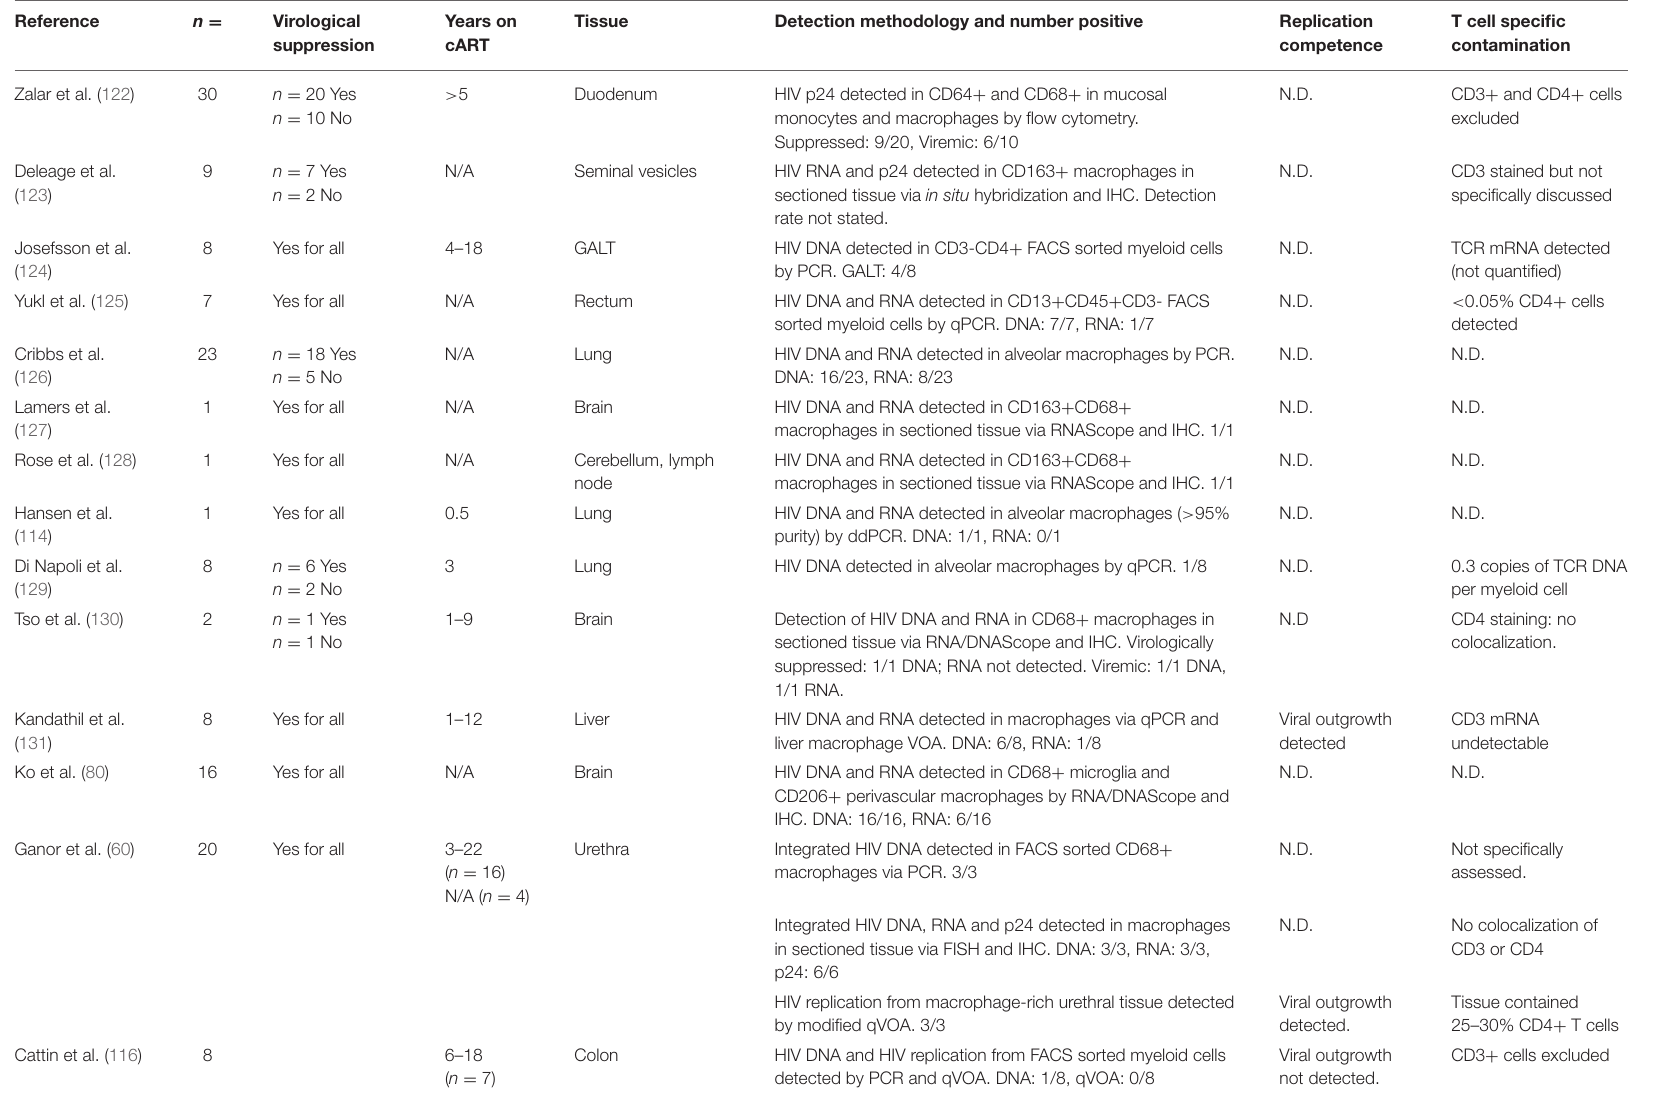
TABLE 2 | Evidence for infection and persistence of HIV in macrophages. Reference